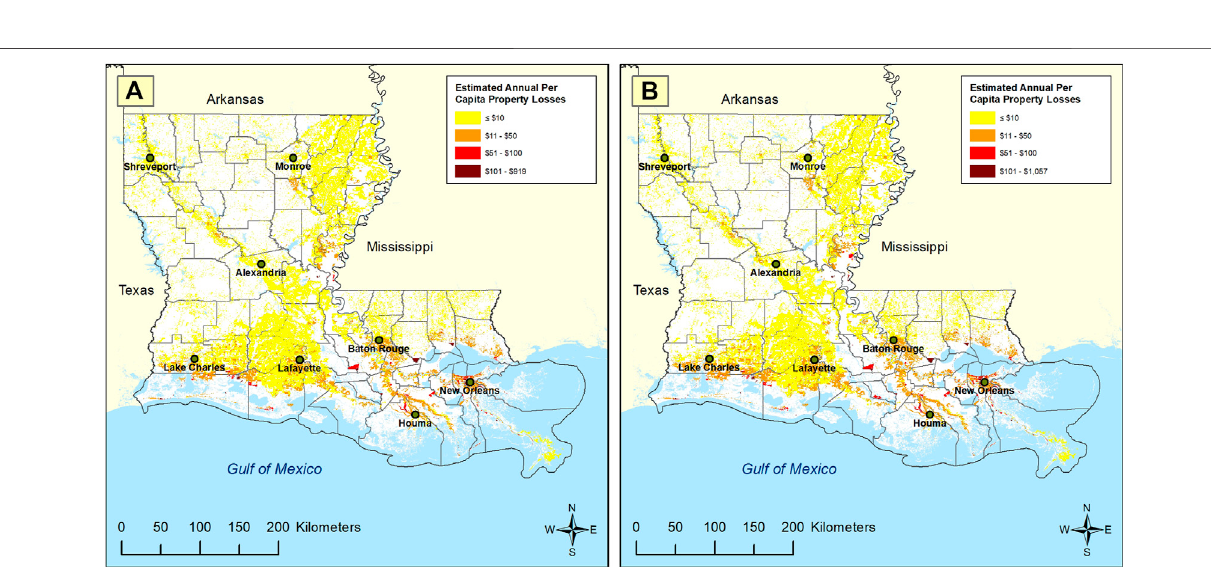
Frontiers in Built Environment |